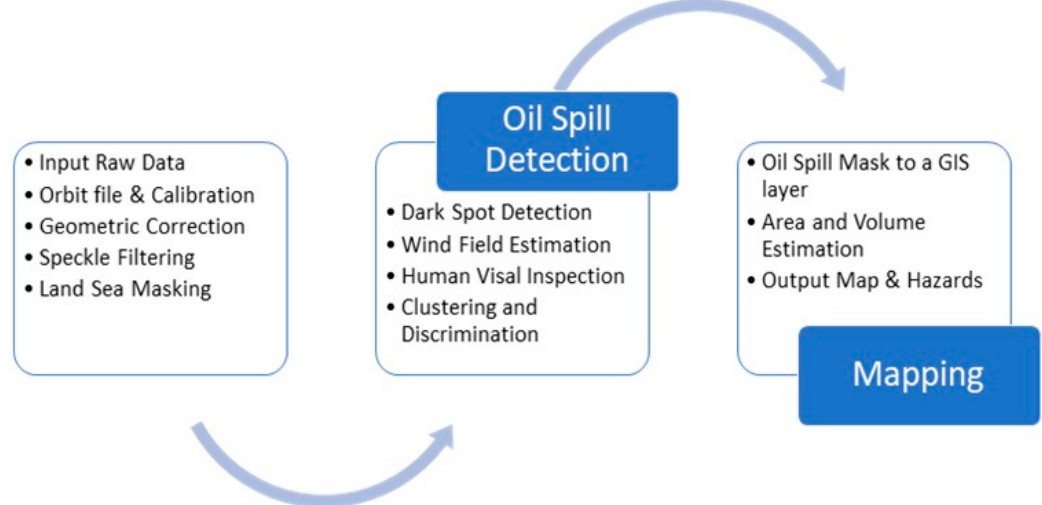
Figure 3. A schematic logical model framework of data processing .